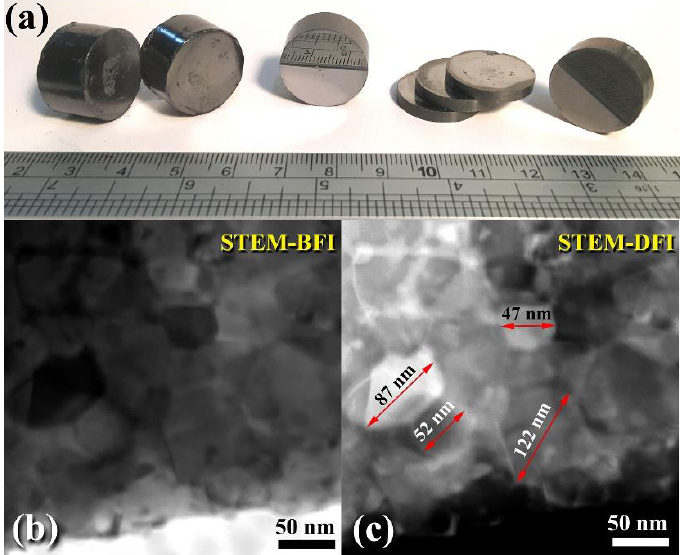
Figure 15. ( a ) A photograph demonstrating the shapes and sizes of various WC consolidated buttons obtained after the powders for the final product were consolidated (20 h) using the SPS method at 1250 °C. The STEM-BFI and STEM-DFI for the chosen button are depicted in ( b ) and ( c ), respectively.